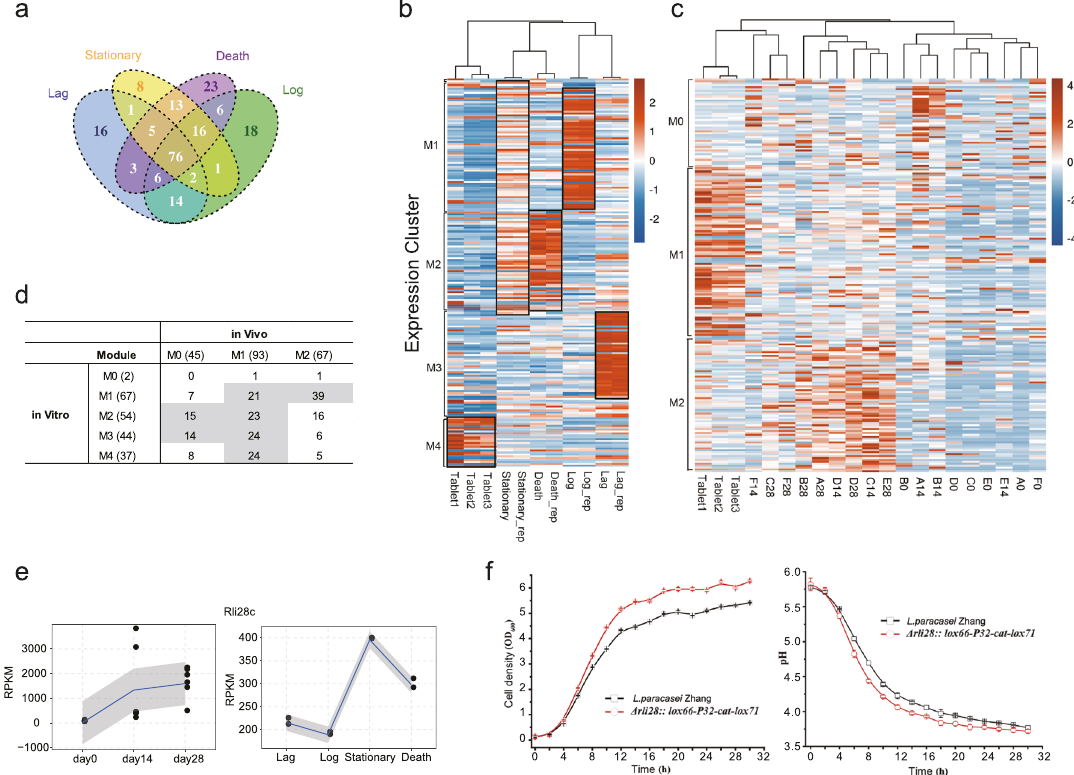
Fig. 3 Expression pro fi le of sRNAs and the function of rli28c sRNA. a Venn diagram showed the sRNA detection overlap among the four growth stages in vitro. b Heatmap presentation of the expression pattern for the in vitro and tablets samples by WGCNA clustering. Black rectangle represents the highly expressed sRNAs in the corresponding samples. c The same with ( b ) but for the in vivo and tablet samples. d The overlapped sRNAs numbers for major modules classi fi ed by WGCNA for in vitro and in vivo shown in ( b ) and ( c ). e The expression level line plot of RPKM values for rli28c sRNAs in in vivo and in vitro samples, respectively. f The cell density (left) and pH value of the growth medium (right) plot by time with (red) and without (black) the rli28c sRNA knockout. Three biological replicates were used in this